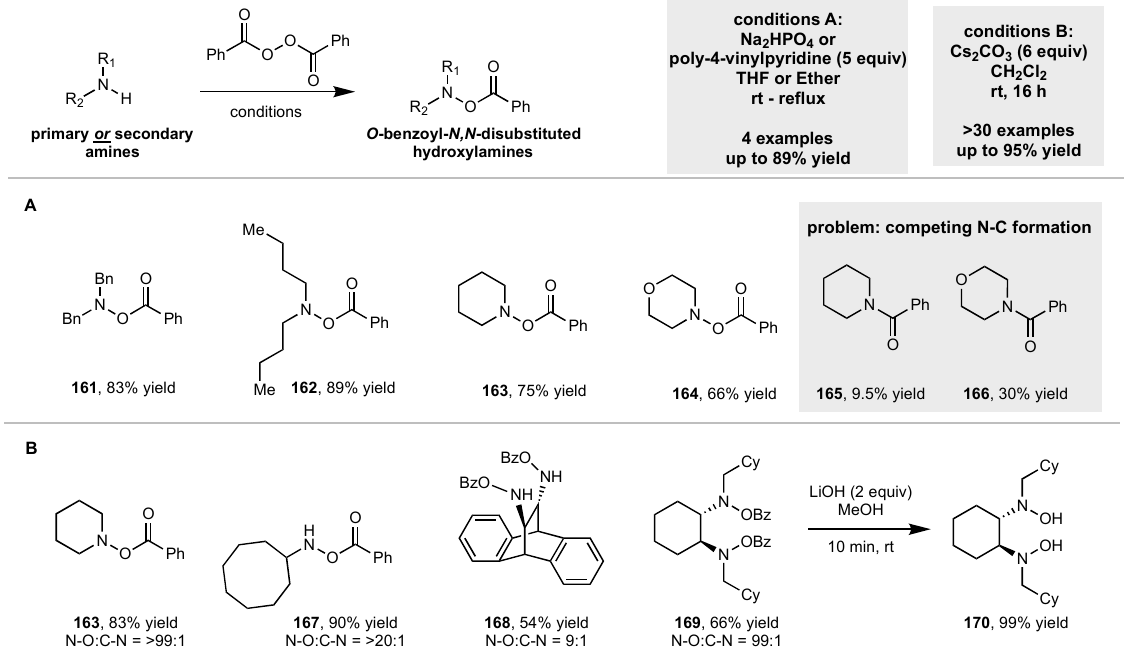
Scheme 17. Ganem and Yamamoto’s syntheses of O -acyl- N , N -disubstituted hydroxylamines. ( A ) Selected examples and limitations of Ganem’s method (conditions A). ( B ) Selected scope and re- lated derivatization of Yamamoto’s optimized method to reduce competing C-N bond